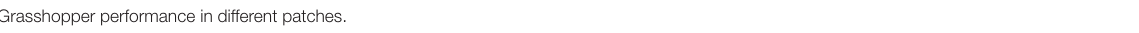
Patch plant community conditions including plant diversity, coverage, biomass, plant density and height are shown in the table. Sk, Cs, Lc, and Af indicate patches dominated by Stipa krylovii, Cleistogenes squarrosa, Leymus chinensis, Artemisia frigida, respectively. Table values indicate mean ± SEM. Those marked by lowercase letters are significantly different within each row based on Tukey’s Studentized Range (HSD) at P < 0.05. TABLE 2 | Grasshopper performance in different patches. Patches